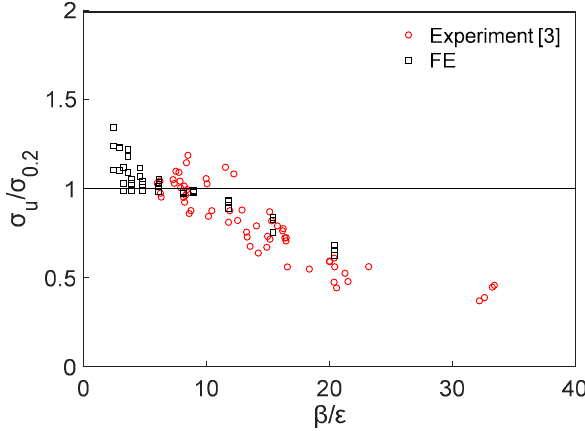
Figure 8. Normalised maximum stresses σ u / σ 0.2 versus slenderness β / ε .